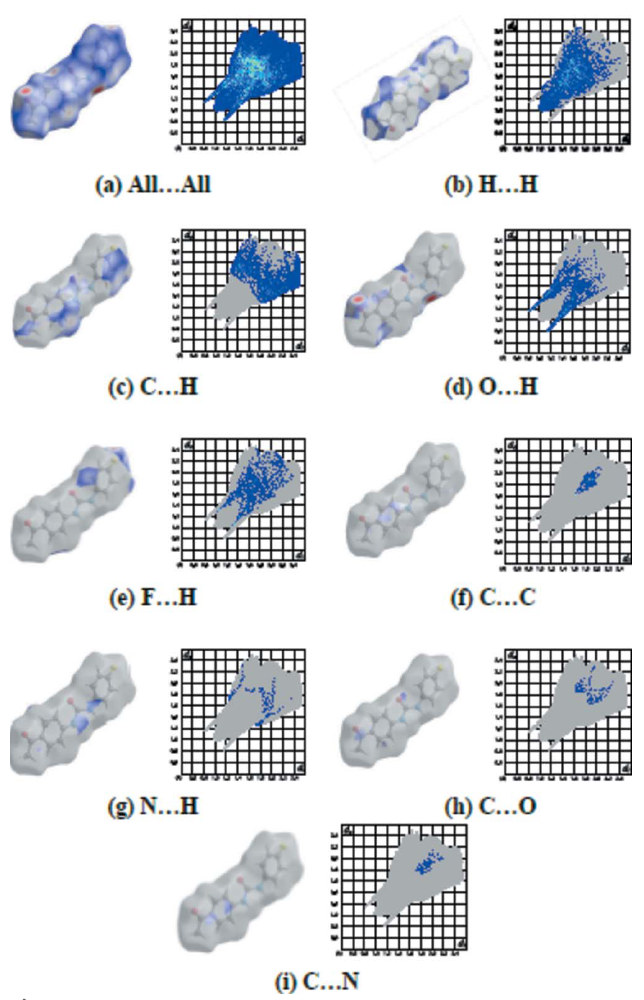
Fig. 5. The three-dimensional shape-index surface of the title compound is shown in Fig. 6.